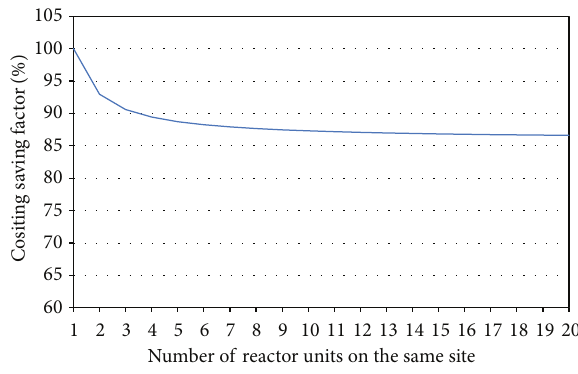
Figure 4: Cositing economies: site-related, fixed cost sharing by multiple units on the same site.